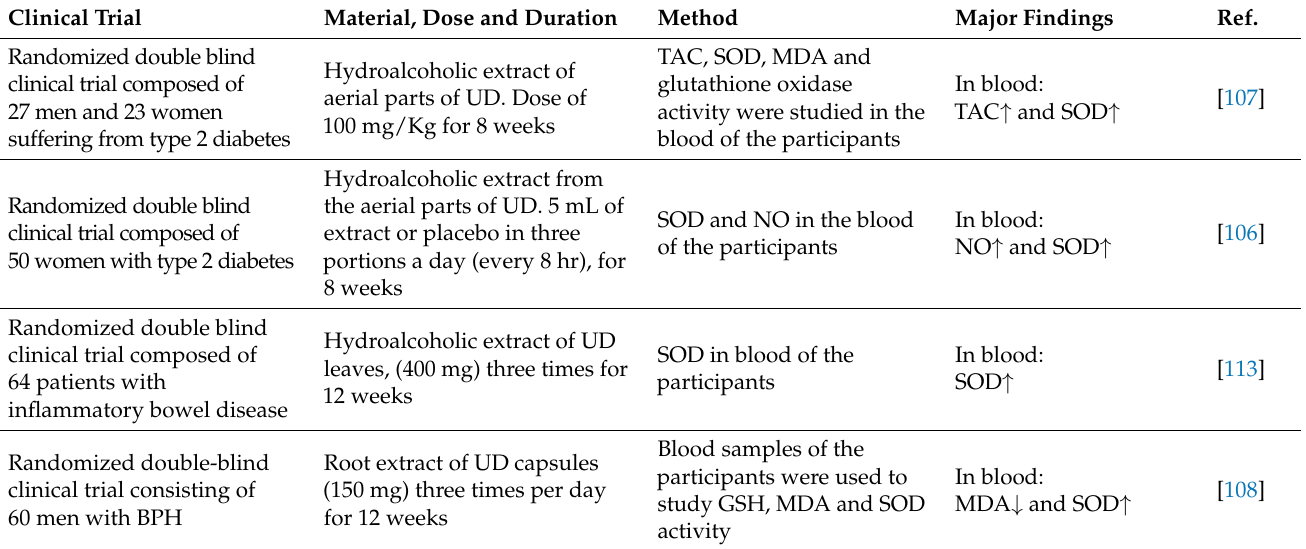
Table 3. The antioxidant activity of UD studied in